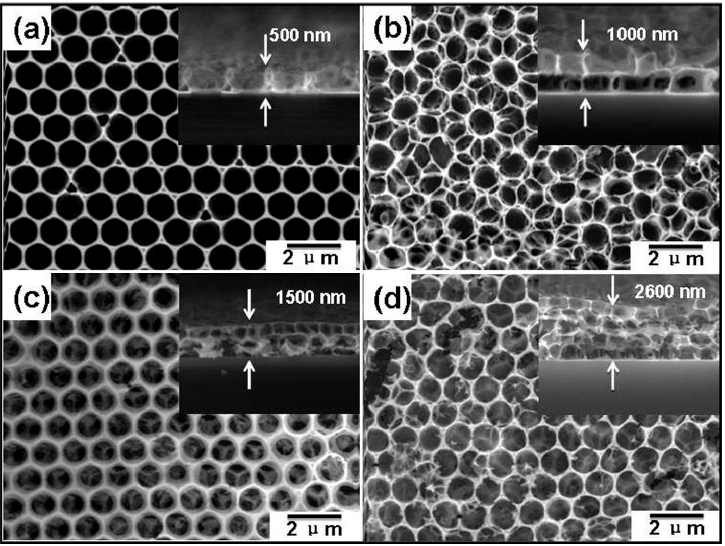
Figure 7. Comparison of sensing response towards various gas samples for the cases of thin and thick ZnO film. Reproduced with permission from [9].